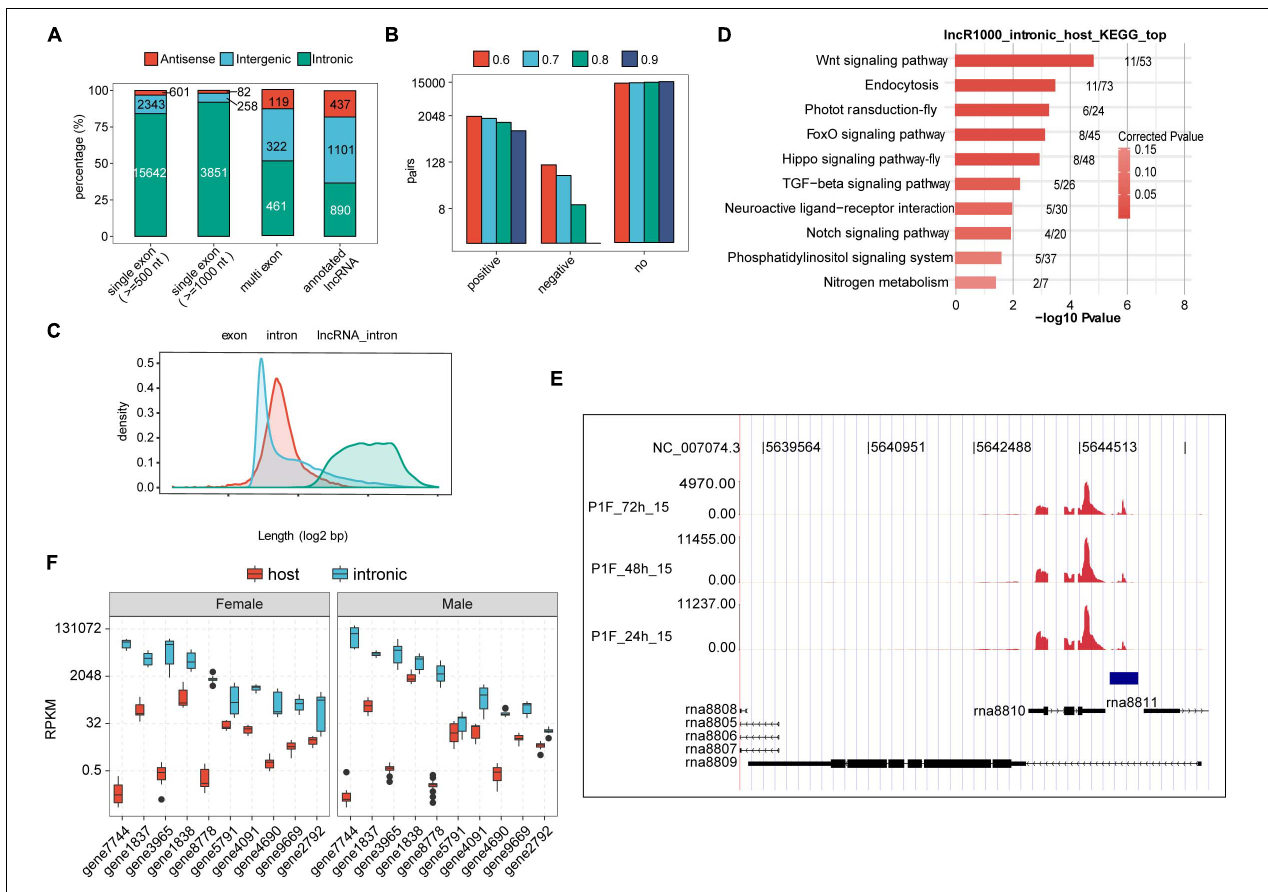
FIGURE 2 | Embryonic honeybee lncRNAs are dominantly intronic. (A) Bar plot showing the genomic locus distribution of the newly identified and previously annotated lncRNAs in honeybee. Single exonic lncRNAs were selected with two thresholds (1,000 and 500-nt). The genomic distribution of the newly identified single-exonic, multiple-exonic lncRNAs and the annotated lncRNAs is shown. (B) Bar plot showing the number of co-expressed pairs between intronic lncRNAs and their host mRNAs by PCC calculation. Four PCC thresholds were shown in the figure. No indicated the pairs that were not satisfied with the threshold. (C) Density of the length distribution of exons and introns of honeybee. Introns containing lncRNAs (500-nt threshold for single exon lncRNAs) were plotted separately. The length density distribution was generated by density function in R. (D) The top 10 functional enriched KEGG pathways of genes encoding intronic lncRNAs (1,000-nt threshold for single exon lncRNAs). (E) Reads density plot showing the prevalent transcription in intronic region. Blue frame indicates the newly predicted transcript in the intronic region of rna8809. The annotated intronic lncRNAs rna8810 and rna8811 were transcribed extensively as well. (F) Box plot showing the higher expression levels of intronic transcripts than their host exonic mRNAs in both female and male